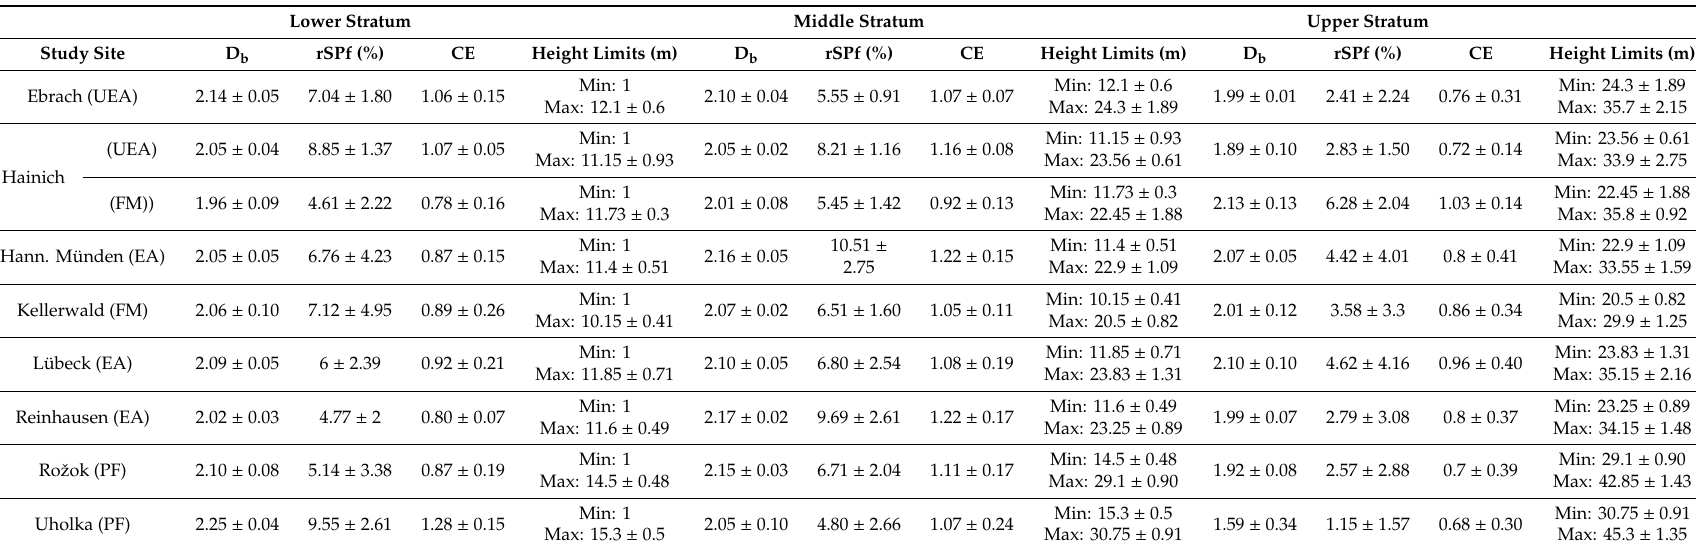
Table 2. Box-dimension (D b ), relative space filling (rSPf%), Clark–Evans index (CE), and the height limits (m) of the lower, middle, and upper forest stratum of the forest stands in the di ff erent study sites (mean ± standard deviation). Mean D b is defined as the arithmetic mean of the D b values calculated for the lower, middle, and upper forest stratum of each forest stand within the di ff erent study sites. Mean rSPf [%] and mean CE is defined as the arithmetic mean of the rSPf [%] and CE values calculated for 5% high forest strata within the lower, middle, and upper layer of each forest stand in the di ff erent study sites. Sample sizes for even-aged (EA) managed study sites were: Hann. Münden ( n = 4), Lübeck ( n = 4), and Reinhausen ( n = 4). Sample sizes for uneven-aged (UEA) managed study sites were: Ebrach ( n = 4), Hainich-Dün ( n = 4). Sample sizes for formerly managed (FM) study sites were: Hainich-Dün ( n = 7), Kellerwald ( n = 4). Sample sizes for Primary forests (PF) were: Rožok ( n = 4) and Uholka ( n =